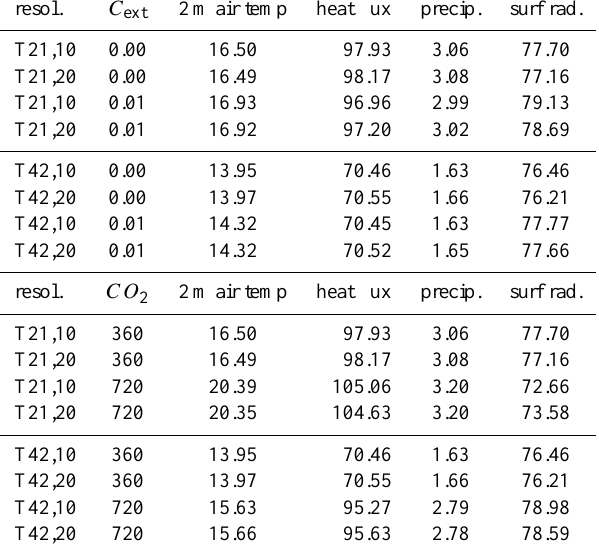
Table 2. The area-weighted mean climatic variables of all non- glaciated land points for the control simulation ( C ext =0.00 and CO 2 =360ppm), C ext =0.01 for maximum wind power extraction, and an atmospheric CO 2 =720ppm simulation are shown. The associated climatic variables have the following units: tempera- ture in ◦ C, heat flux (latent+sensible) in Wm − 2 , precipitation in mmday − 1 , and surface thermal radiation in Wm 2 .